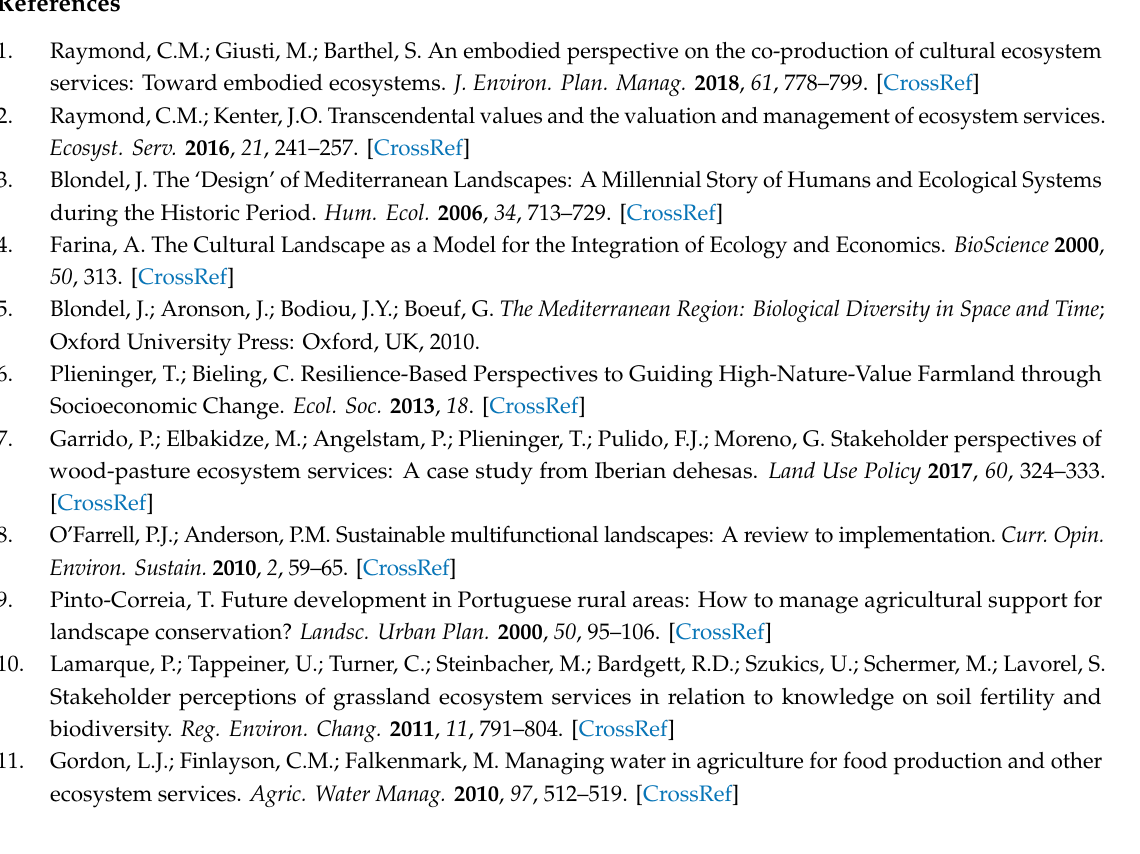
Figure S1: Dendrogram of the Hierarchical Clustering Analysis to classify municipalities into social-ecological sectors; Figure S2: Photographs used for the preference ranking; Table S1: Variables used to classify municipalities in social-ecological sectors. To develop a socioecological characterization of the study area, socioeconomic data together with land use / land cover data of the municipalities (Table S1) were analyzed. A Principal Component Analysis (PCA) (Table S2) and an agglomerative Hierarchical Clustering Analysis (Euclidean distance, Ward method) (Figure S1) allowed the identification of three homogeneous groups of municipalities (level of confidence 95%) regarding the association of their relevant socioeconomic and natural capital features. We called this three group of municipalities: Socioecological Sectors (Table S3), Table S2: Loadings of the 9 first axis of the PCA performed to the socioecological descriptors in order to classify the municipalities into socioecological sectors; Table S3: Characterization of social-ecological sectors: relevant biophysical and social descriptors with high levels in each sector; Table S4: variables used to define stakeholder clusters; Table S5: Descriptors of the experts interviewed; Table S6: Visual characteristics of the photographs used in preference ranking; Table S7: Description of the ecosystem services analyzed in the study; Table S8: coordinates of RDA response variables (ranking values) and explanatory variables; Table S9: Means of ecosystem services delivery scores for each landscape unit; Table S10: Results of Kruskal-Wallis test performed for ecosystem services between landscape types; Table S11: Results of Kruskal-Wallis test performed for each stakeholder